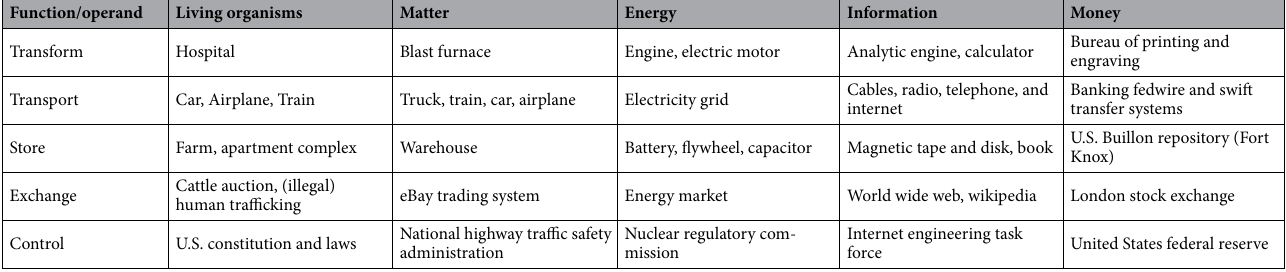
Table 1. A classification of engineering systems by function and operand 3